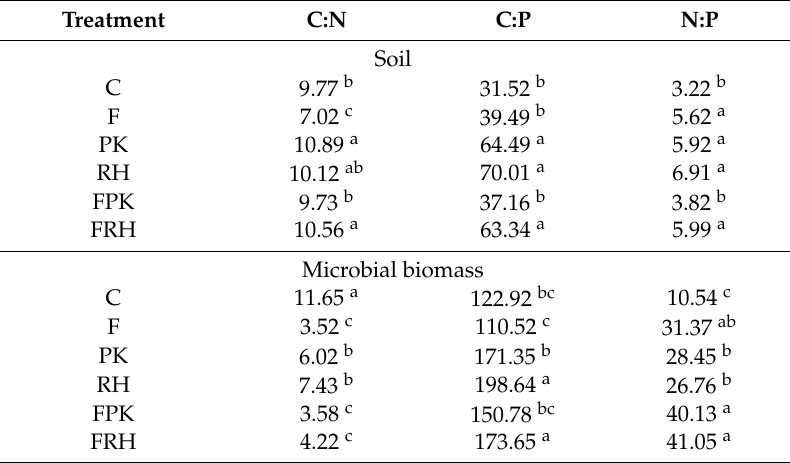
Table 4. Molar C:N:P ratios in soil and microbial biomass. Treatment